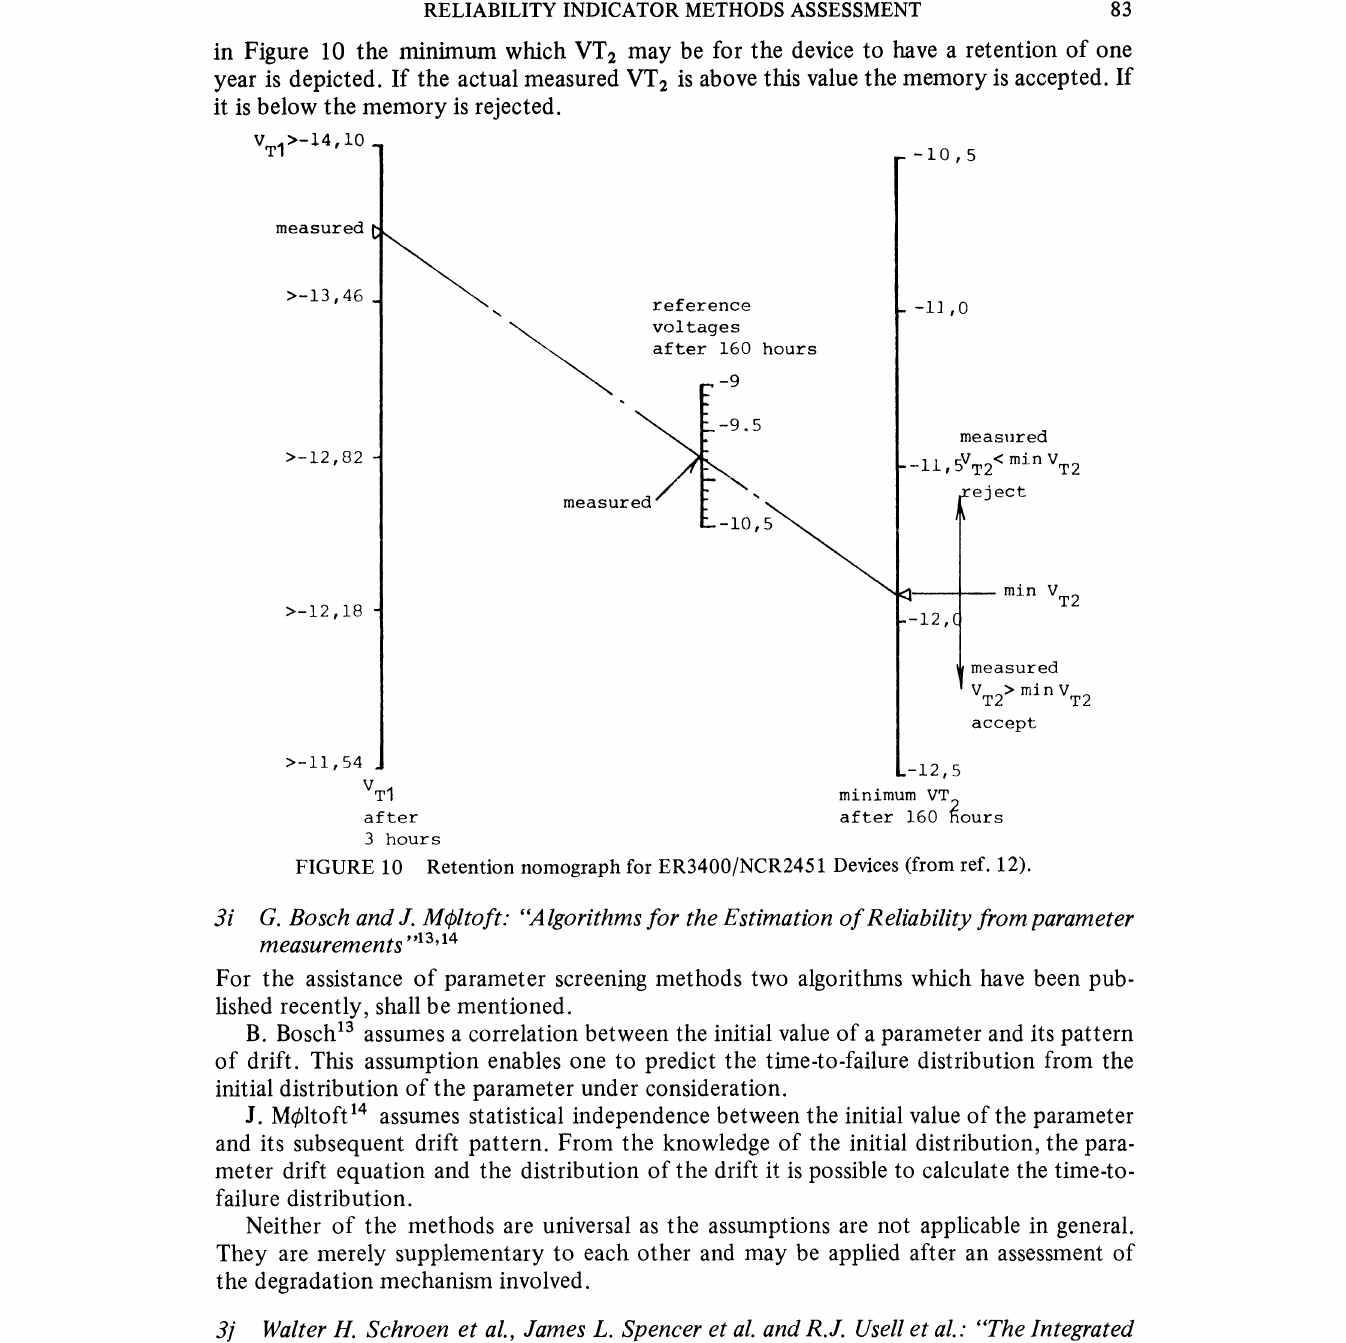
in Figure 10 the minimum which VT: may be for the device to have a retention of one year is depicted. If the actual measured VT: is above this value the memory is accepted. If it is below the memory is